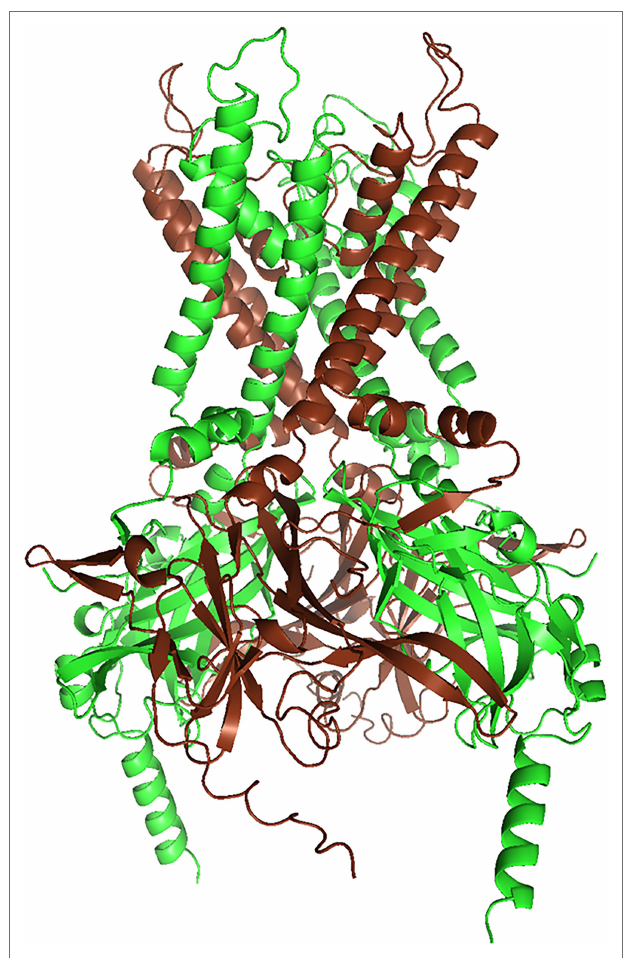
FIGURE 1 | Structural model of the Kir4.1/Kir5.1 heteromer (rendered with PyMol 2.5.2) of a Kir4.1/Kir5.1 model generated with AlphaFold Multimer (Jumper et al., 2021, Evans and O’Neill, https://www.biorxiv.org/content/10.1 101/2021.10.04.463034v1). We truncated both N- and C-termini slightly, to reduce complexity. AlphaFold yielded three models with almost identical ranking, but only one of them conformed to the alternating subunit structure postulated by Lagrutta et al. (1996). Kir4.1 subunits are brown, and Kir5.1 subunits are